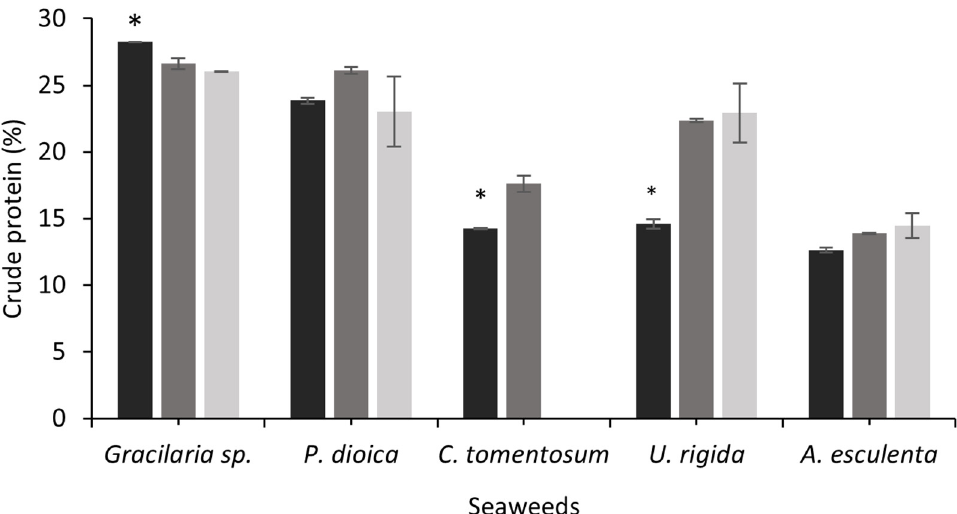
Figure 1. Crude protein content of unfermented seaweeds (black bars) and fermented seaweeds with A. ibericus MUM 03.49 (gray bars) and A. niger CECT 2915 (light gray bars). Results are presented as the mean (n = 3) ± SD. * denotes significant differences between unfermented and fermented seaweeds (Tukey’s test; p < 0.05) comparing each seaweed species. During SSF, the filamentous fungi partially degrade the substrate’s structural matrix through the production of carbohydrate-degrading enzymes [63]. The carbohydrate content before and after the seaweeds’ SSF is shown in Figure 2. The U. rigida carbohydrate content decreased by 54% ( A. ibericus) and 62% ( A. niger) after SSF ( p < 0.05), while no differences were observed for the other seaweeds before and after SSF. As previously observed, the SSF of U. rigida also resulted in the highest enzyme production among all the seaweeds. According to Fernandes et al. [17], the SSF of unwashed U. rigida with A. ibericus led to a higher total polysaccharide reduction, along with higher cellulase and xylanase production. The same correlation between polysaccharide reduction and enzyme production was also observed using other substrates in SSF, such as brewer’s spent grain [63], or soybean and rapeseed cakes [56]. Figure 2. Carbohydrate content of unfermented seaweeds (black bars) and fermented seaweeds with A. ibericus MUM 03.49 (gray bars) and A. niger CECT 2915 (light gray bars). Results are presented as the mean (n = 3) ± SD. * denotes significant differences between unfermented and fermented solids (Tukey’s test; p < 0.05) comparing each seaweed species.